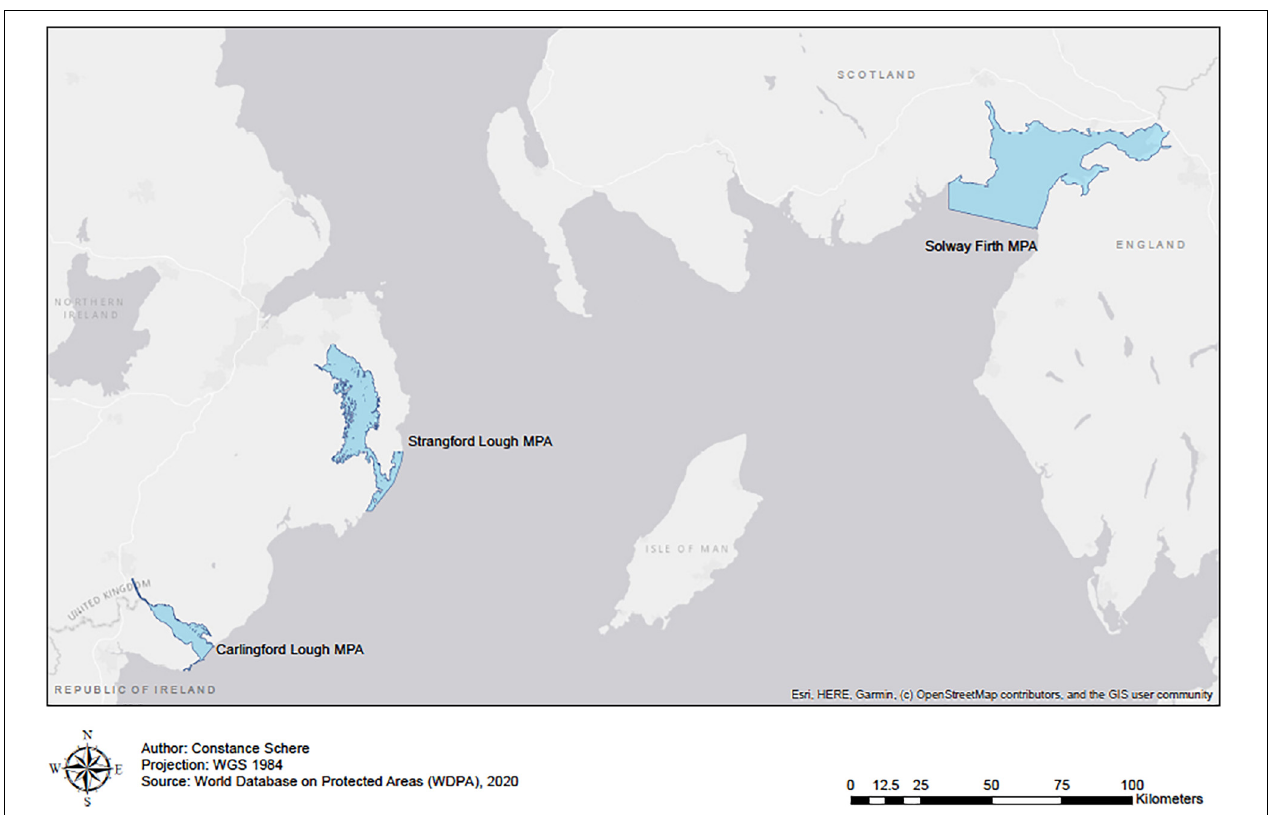
FIGURE 1 | Case study MPAs in the Irish